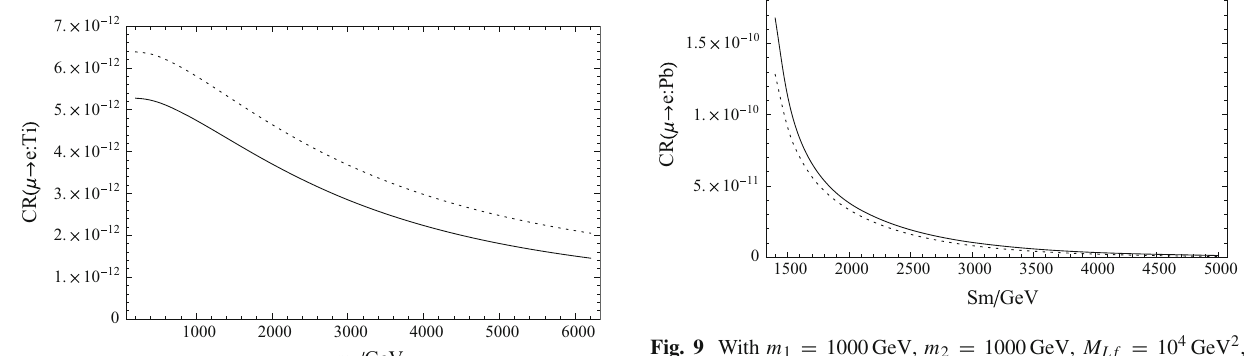
tributions. With S 2